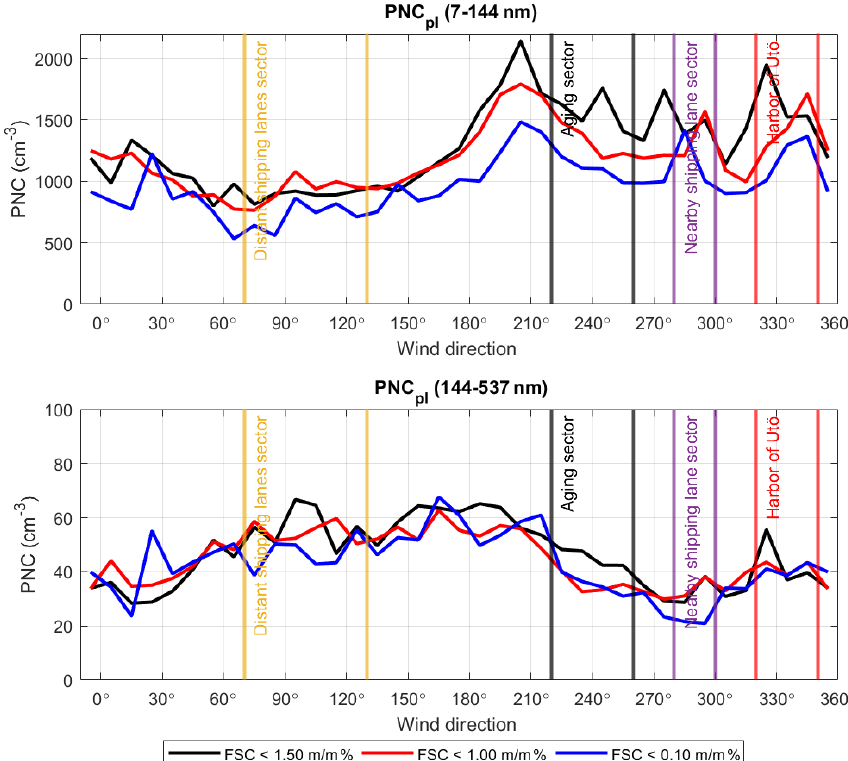
Figure 8. Particle number concentrations of the plume particles (PNC pl ) in size ranges from 7 to 144nm and from 144 to 537nm averaged for the 10 ◦ sectors. The distant shipping lanes sector, aging sector, nearby shipping lane sector, and harbor of Utö are marked using pairs of vertical